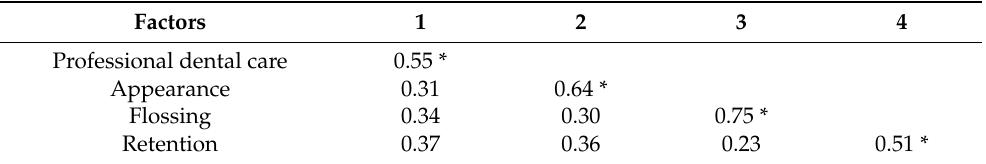
Table 5. Discriminant validity: Fornell–Larcker